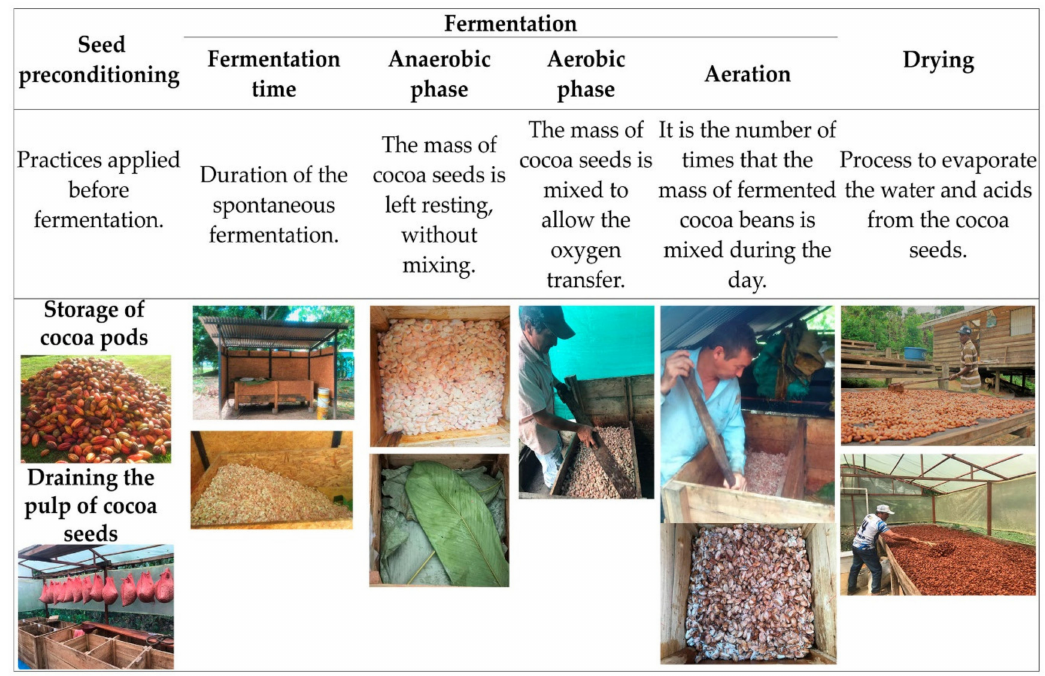
Figure 8. Stages of cocoa processing employed as variables for the cluster analysis of cocoa